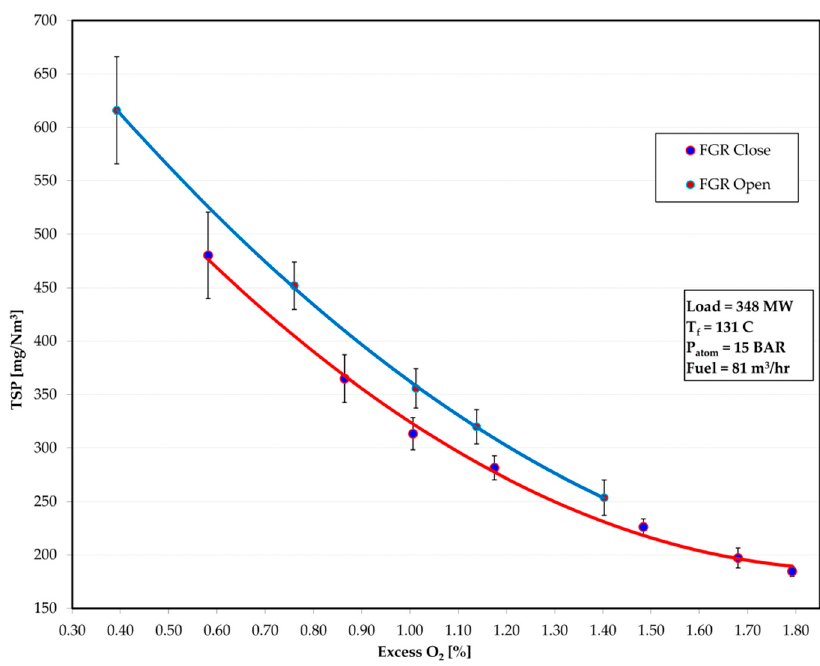
Figure 3. Effect of O 2 excess and FGR gate opening level on TSP emissions.